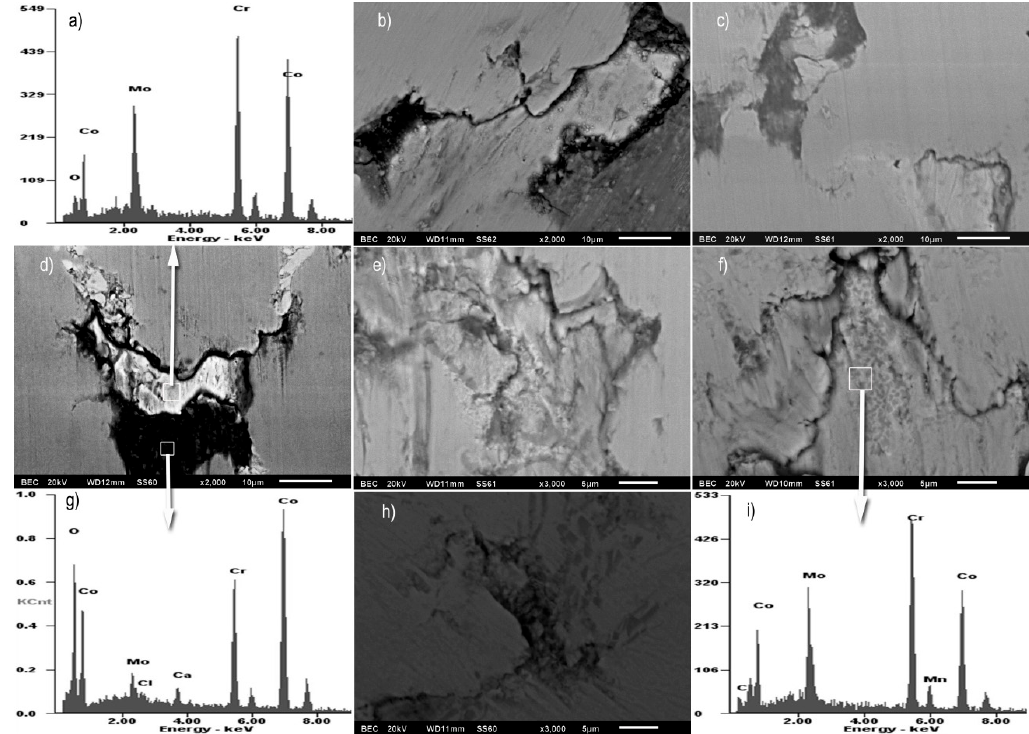
Figure 9. Fatigue delamination; ( a ) EDS in 0.25B-AC, ( b ) 0B-HT 8 km, ( c ) 0.06B-HT 12 km, ( d ) 0.25B-AC 8 km, ( e ) 0.5B-AC